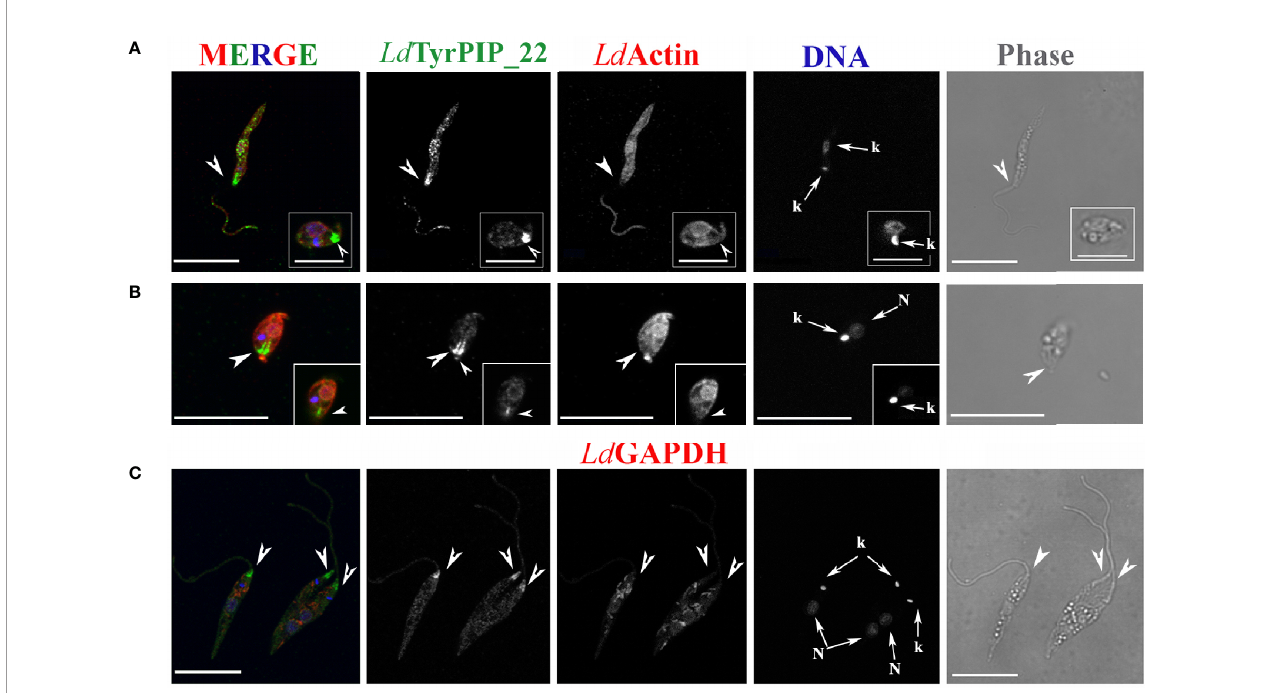
FIGURE 7 | Localization of Ld TyrPIP_22 epitopes in tationary phase L. donovani parasites after 24 h exposure at 37°C and pH 5.5. Co staining with Ld Actin and Ld GABDH. Confocal microscopy images of L. donovani promastigote- and amastigote – like forms. Double IF staining of fi xed cells permeabilized with 0.1% (v/v) TritonX-100 was performed with the anti- Ld TyrPIP_22 mouse pAb (1:100) and the anti- Ld Actin rabbit pAb (1:1,000) in (A, B) or the anti-GAPDH rabbit pAb (1:100) in (C) followed by secondary Abs conjugated to Alexa Fluor ® 488 or Alexa Fluor ® 546. Nuclear and kinetoplast DNA was stained with Hoechst 33342 (1:5,000). In (A, C), single z-sections of axenic promastigote-like forms. Inset in (A) : an amastigote-like parasite from the same fi eld at a 2X magni fi cation. In (B), the maximum intensity projection of an amastigote-like parasite (i.e., smaller than promastigotes, ovoid, with retracted/short fl agellum). Inset in (B) : a single z-section at the same magni fi cation as the maximum intensity projection. Single FL and phase contrast images are presented in BW while images of the three FL signals merged are shown in color. The molecule highlighted in the BW images with single color FL is indicated at the top in the same color of the respective FL signal. Images were acquired with a Leica TCS SP8 confocal microscope by z-scanning performed at 0.3 m m step size. Large arrowheads point to the fl agellar pocket/base of fl agellum. Small arrowhead in inset (B) , shows the small fl agellum. Small arrows in (A – C) point to the kinetoplast (k) and nucleus (N). Scale bar size in A-C: 10 m m. Inset (A) scale bar size: 5 m